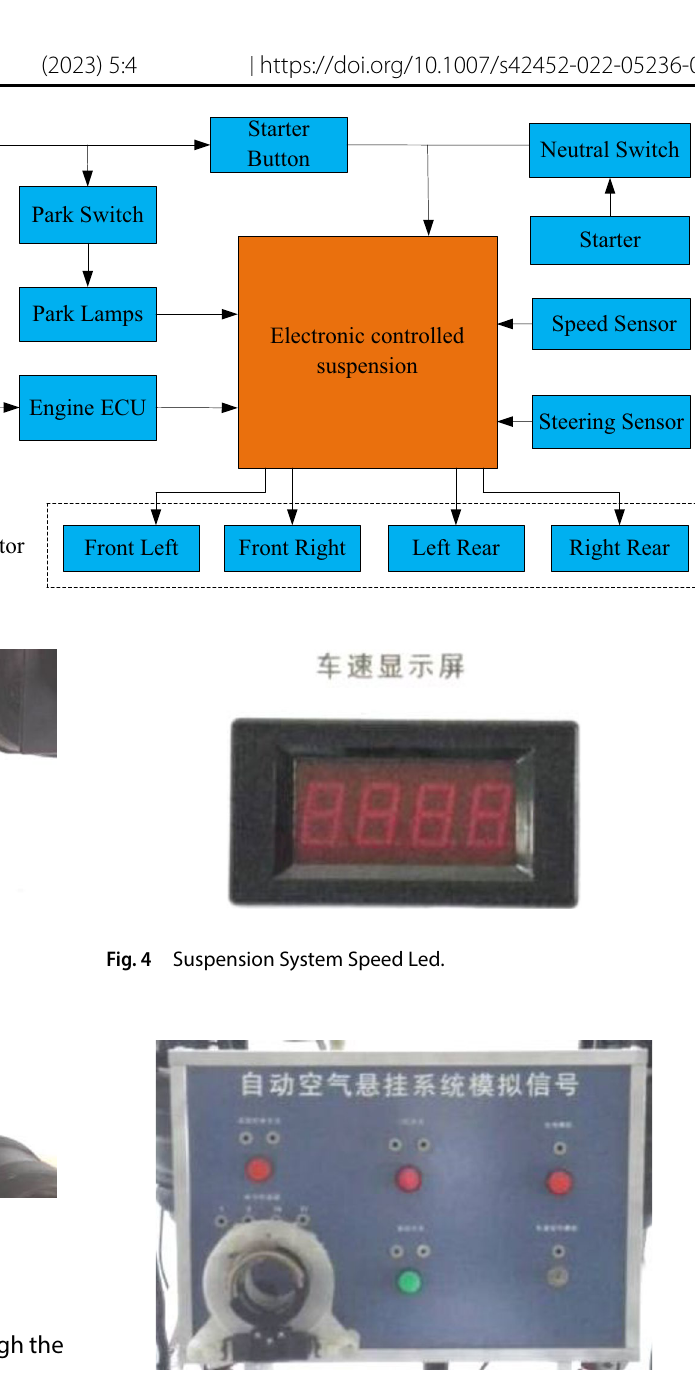
Fig. 5 Analog Signal Input